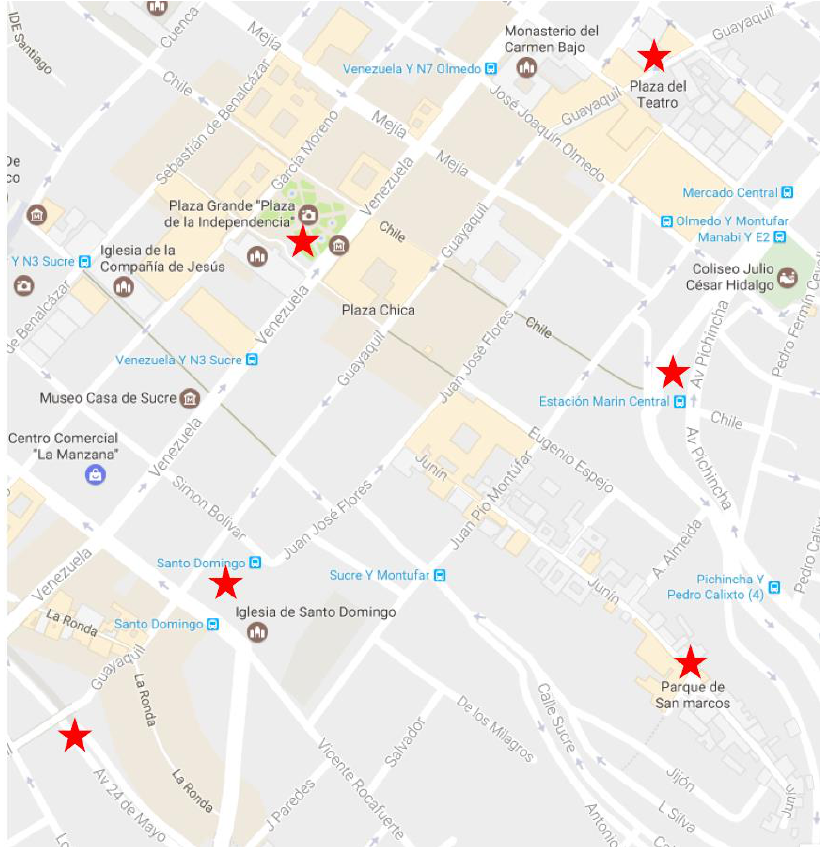
Figure 7. Map of the Historic Center of Quito. Red stars indicate approximate locations where street-based sex workers concentrate, based on interview data and Á lvarez and Sandoval [41]’s findings. Map from Google Maps .